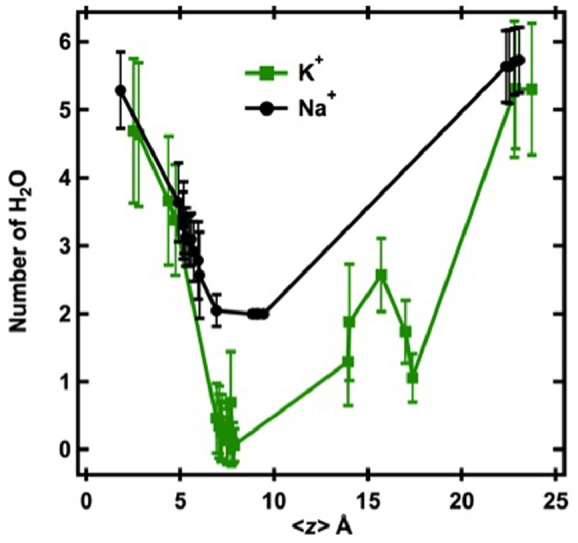
The number of water molecules within 3 Å of Na+ and K+ ions as they are pulled incrementally through the selectivity filter of KcsA from the cytoplasmic side of the membrane (left) to the extracellular surface of the membrane (right).On the x-axis, z = 0 corresponds to the center of mass of the system in the vestibule of the channel. The first data point on the left is a position in the vestibule below site S4. Site S4 is located at z≈7 Å. Values shown are means ± SD.